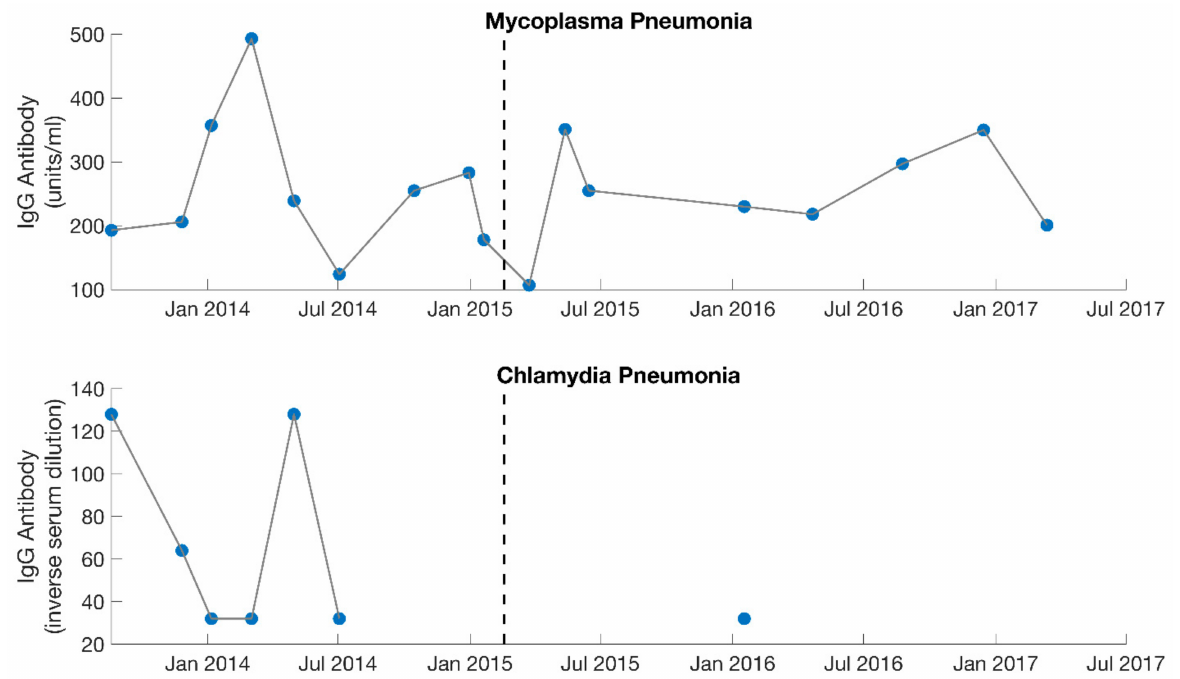
Figure 3. Serology results from IgG specific antibody levels for both Mycoplasma pneumonia and Chlamydia pneumonia. Dotted lines separate the 2 different phases of treatment (September 2013–February 2015, February 2015–August 2017). With the initiation of treatment, IgG levels rose for Mycoplasma pneumonia but fell for Chlamydia pneumonia. Mycoplasma pneumonia was viewed by the treating physician (MD, PhD) as the dominant contributing factor to the patient’s illness during the first phase of treatment. Large gaps are present for Chlamydia pneumonia as this was not measured consistently.